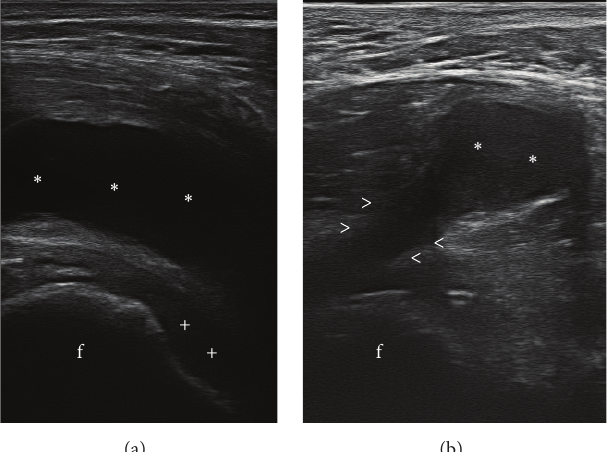
Figure 5: Ultrasound examination of the hip. (a) Longitudinal scan revealing the presence of a neoformation with fluid content (asterisks) anterior to the right hip. In the hip joint, an effusion (+) is present. (b) Semicoronal scan showing the connection between the joint and the formation (arrowheads), f: femoral